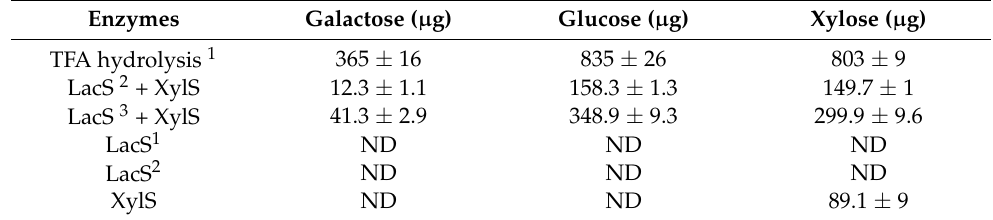
Table 1. Enzymatic hydrolysis of XGO1 after 20 h by using LacS and XylS. Enzymes